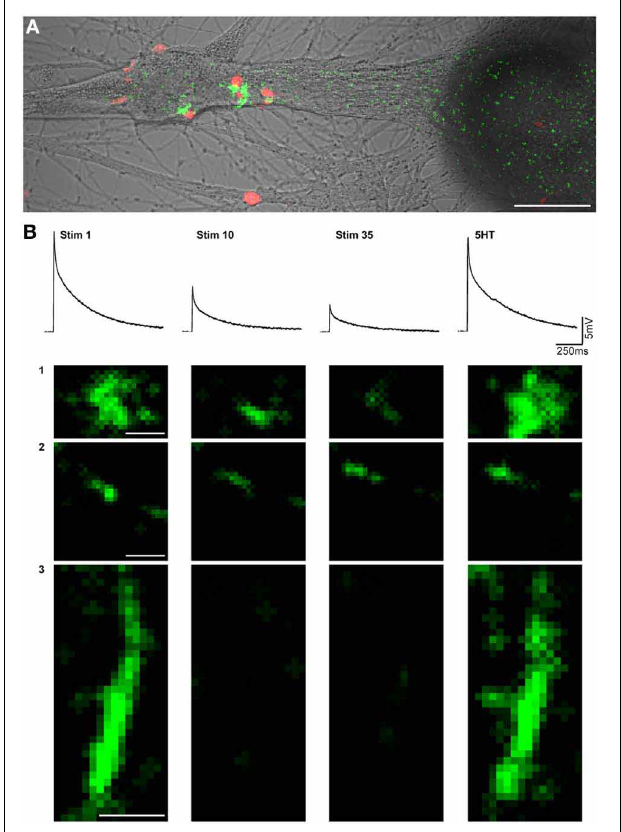
FIGURE 1 | Imaging of excitatory postsynaptic free calcium concentration transients (EPSCaT) during homosynaptic habituation and 5HT-induced dishabituation. (A) Five days after plating, the SN was loaded with the calcium indicator rhod-2 (red), and the L7 was loaded with the calcium indicator fluo-4 (green). The image shown is an overlay of EPSCaTs (green) with apposed presynaptic boutons (red) on a transmitted image of the neurons. The image was processed for display purposes. (B) Sample EPSPS and high magnification images of corresponding EPSCaTs from a different experiment than (A) , monitored during a train of 35 stimuli delivered at 0.05Hz, at three different sites (1, 2, 3). Shown are the 1st, 10th, and 35th stimuli, and the dishabituated signal, 5min after bath application of 5 HT. In the example, the fluorescent intensity of the first EPSCaTs was set to a similar level. In sites 1 and 2 gradual reductions in the intensities were imaged. In site 3 the fluorescent signal disappeared on the 10th and 35th stimulus. 5HT application led to the recovery of the signals in all three sites. Scale bars in A = 20 μ M. In B = 1 μ